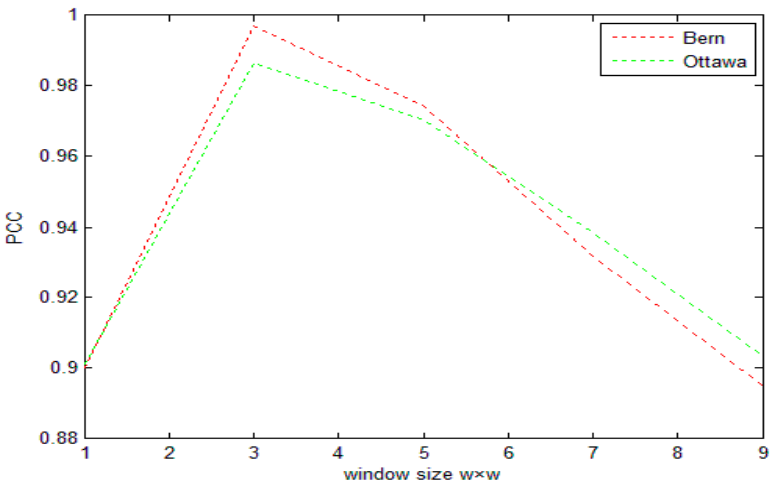
Figure 2. The relationship between window size ω × ω and PCC.